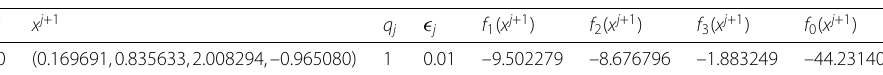
Table 3 Numerical results for Example 4.1 with x 0 =